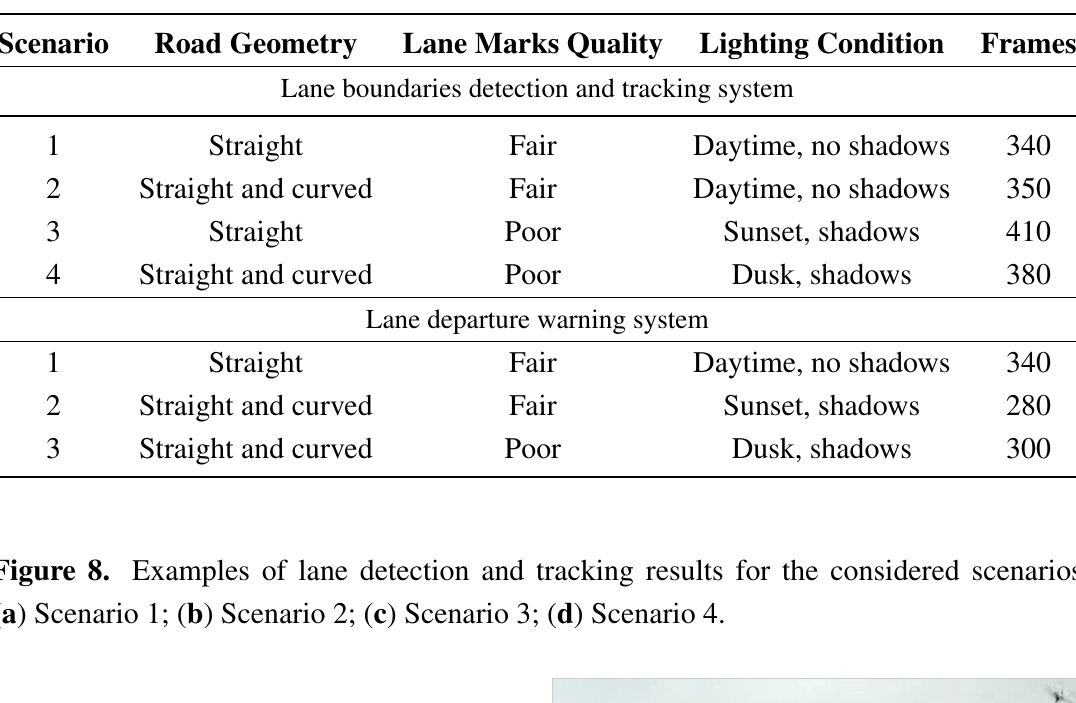
Table 2. Scenarios for the performance evaluation of the lane sensing and departure warning system.